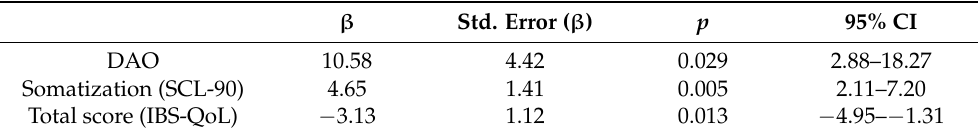
Table 3. Regression analysis between IBS-SSS total score and biochemical, psychological, and QoL